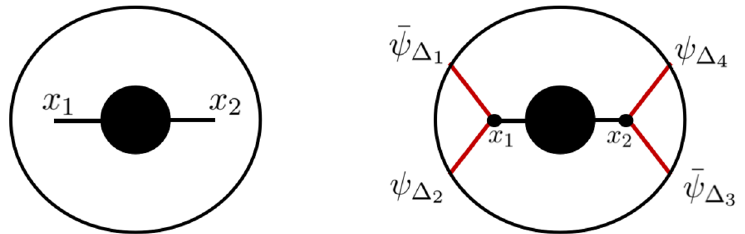
Figure 1 . Left: the black blob represents a general bulk two-point corelator F ( x 1 , x 2 ) , with points x 1 and x 2 . Right: attaching fermionic bulk-to-boundary propagators (red lines) to the 2-point blob gives a CFT 4-point function. This class of diagrams has 2 bulk-to-boundary propagators attached to x 1 and x 2 , and 2 attached to x 2